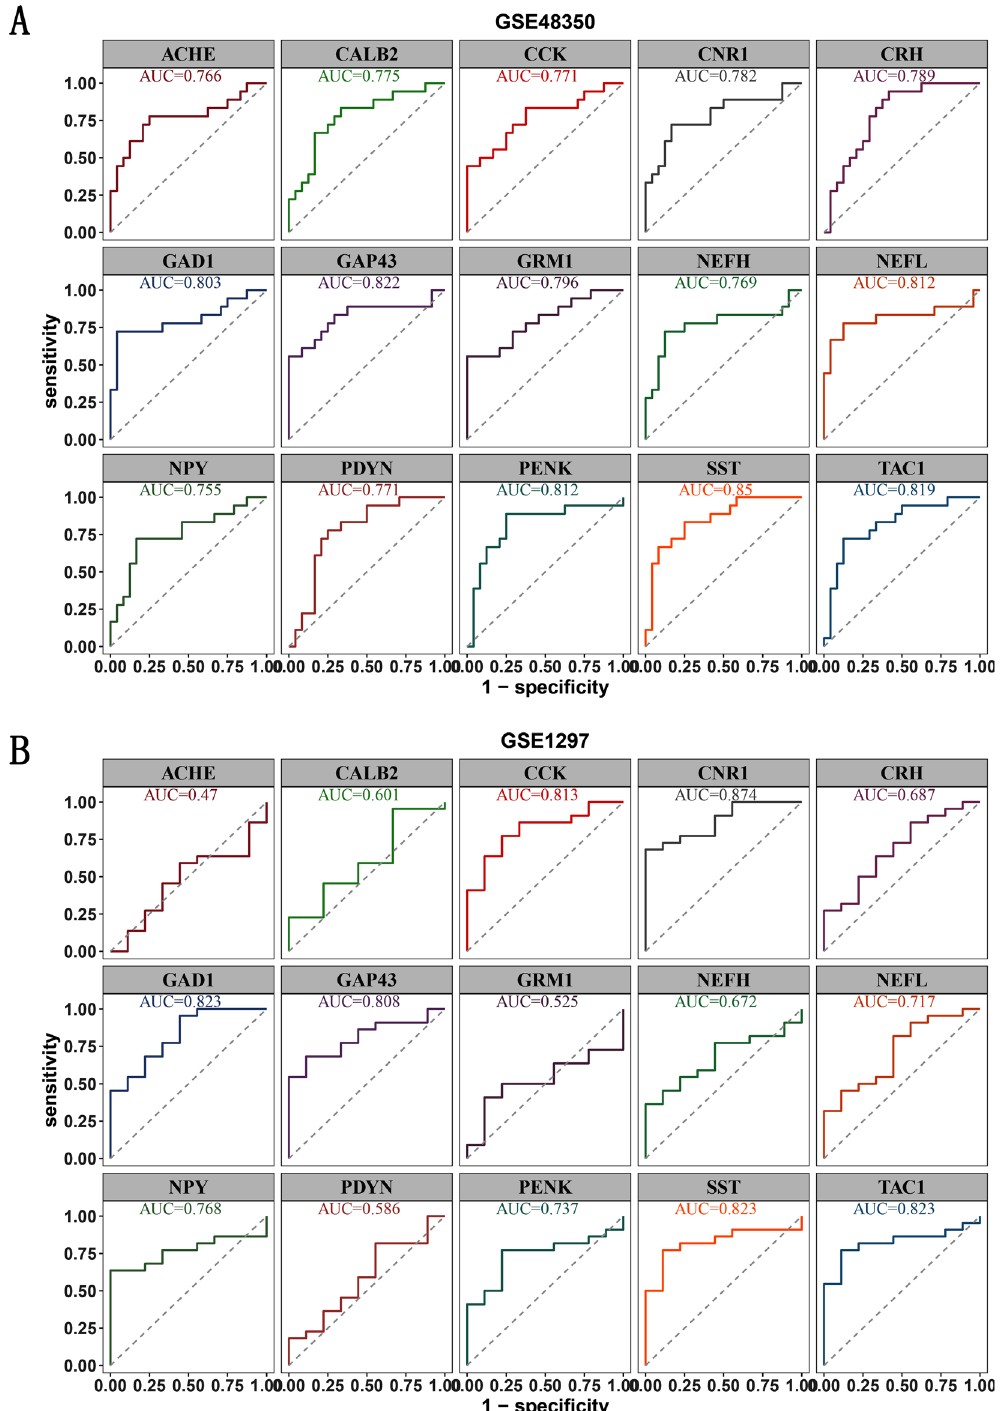
Figure 6. ROC curve validated the diagnostic significance of hub genes for AD in training dataset GSE48350 ( A ) and external validation dataset GSE1297 ( B ). The AUC areas of 9 hub genes (CCK, CNR1, GAD1, GAP43, NEFL, NPY, PENK, SST, and TAC1) were greater than 0.7 in two